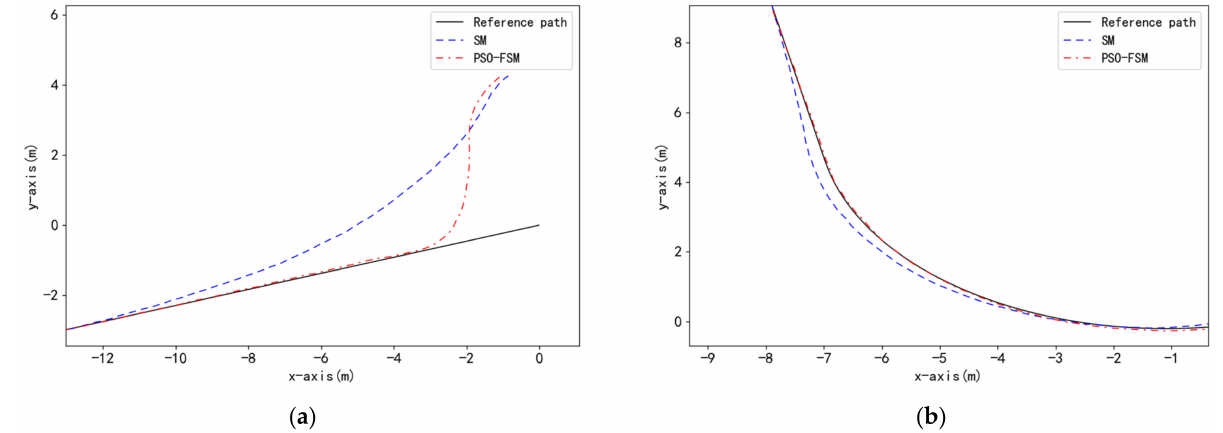
Figure 10. Path tracking result under different scenarios. ( a ) Guiding trajectory with large initial lateral error; ( b ) Curve path tracking of autonomous turning.